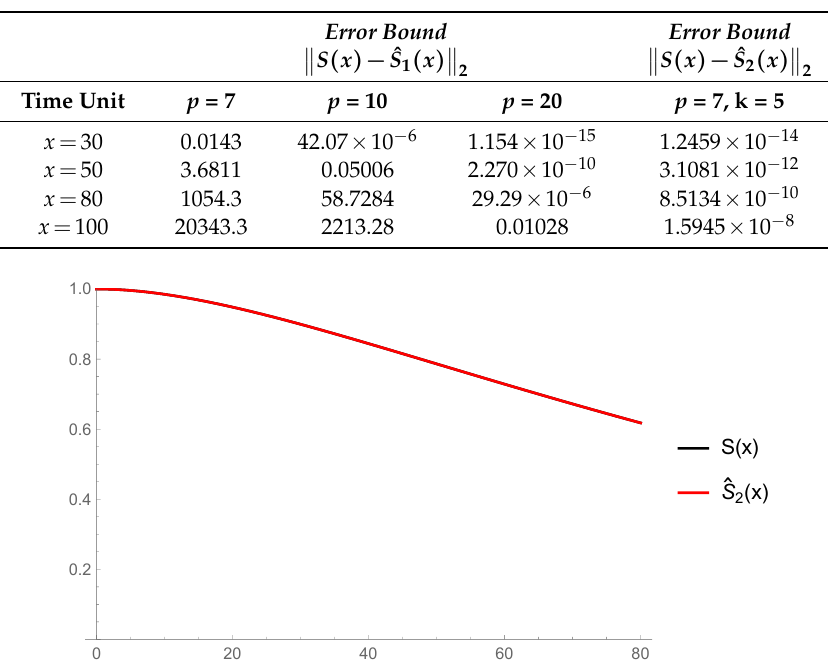
Table 1. Error bound calculated for both approximations, ˆ S 1 ( x ) and ˆ S 2 ( x ) , compared to the exact model S ( x ) in the concatenated Markov process with simulated data from a uniform distribution for the transition rates.